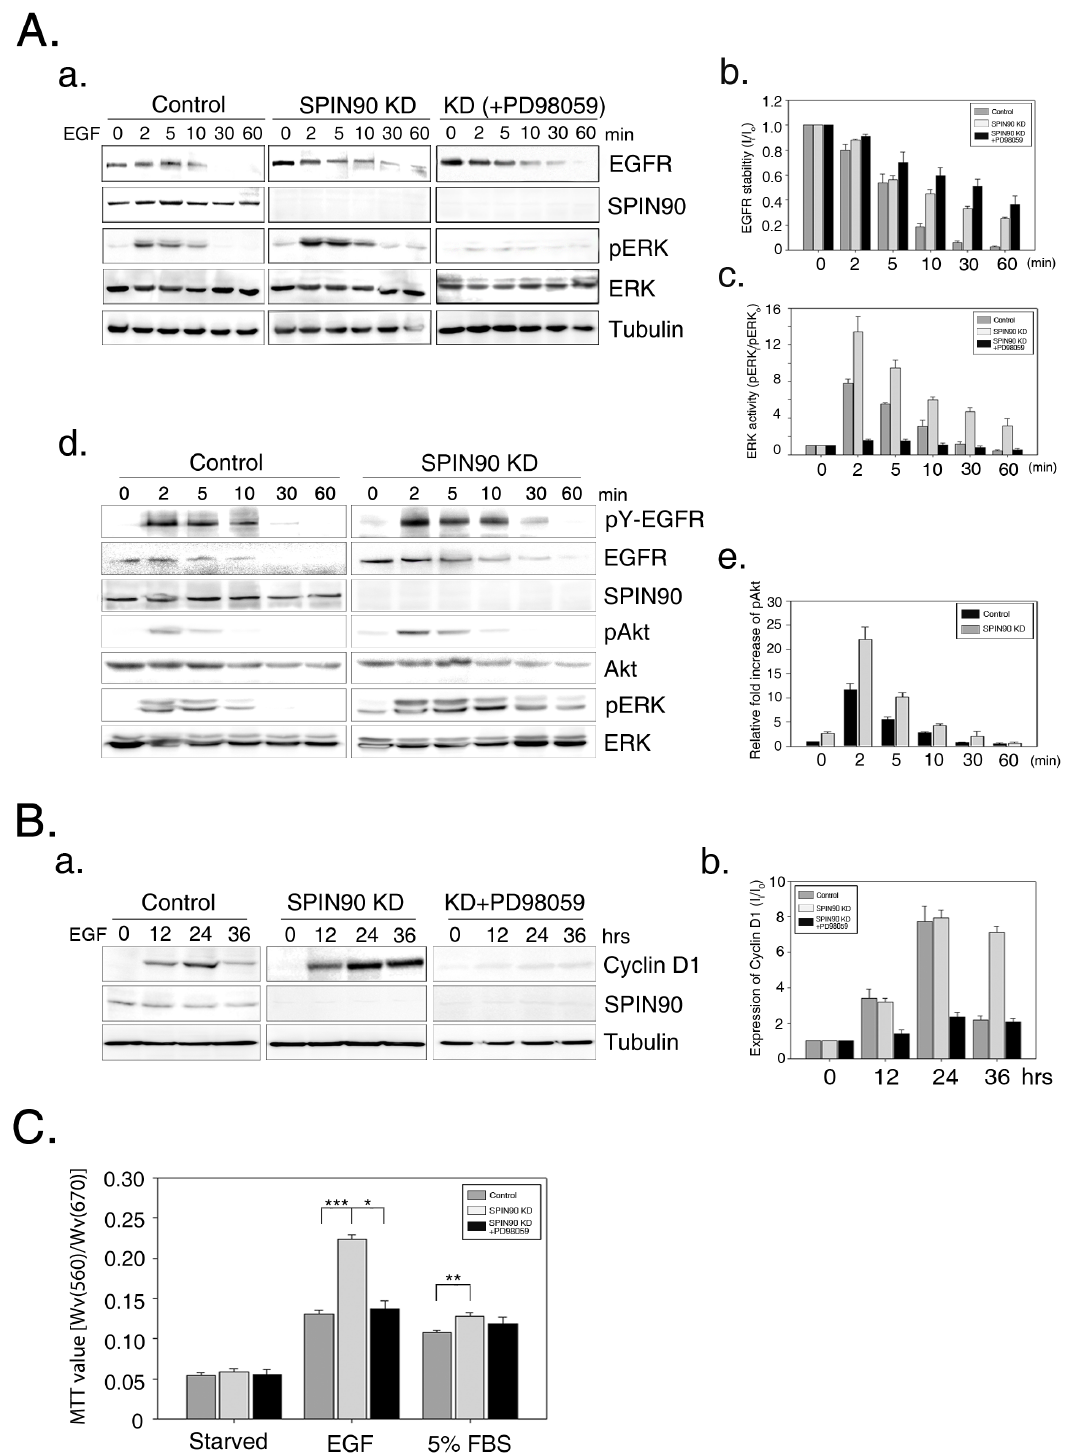
Figure 6. SPIN90 knockdown enhances cell proliferation. A. (a) Control and SPIN90 knockdown (KD) HeLa cells were starved for 16 h, and treated with 40 ng/ml EGF for the indicated times. One set of SPIN90 knockdown cells was treated with 40 ng/ml EGF and 50 m M PD98059 for the indicated times (KD + PD98059). Cell lysates were immunoblotted with the indicated antibodies. (b) Band intensities was normalized to that of tubulin. Bar graphs represent EGFR stability, calculated as the ratio of band intensity of EGFR at the indicated time-points (Ii), compared to that at 0 time (Io). (c) ERK activity is presented as the ratio of band intensity of phospho-ERK (pERK), compared to that of ERK. (d) Experiments were performed the same as Fig. 6A. Cell lysates were immunoblotted with the indicated antibodies. (e) Bar graphs represent active Akt, calculated as the ratio of band intensity of phosphor-Akt (pAkt) compared to total Akt.. B. Control, SPIN90 knockdown (KD) and PD98059 (50 m M)-treated SPIN90 KD HeLa cells starved for 16 h were incubated with 40 ng/ml EGF for the indicated times. PD98059 (50 m M) was used. Cyclin D1 was detected via immunoblot analysis, and the relative values of band intensities calculated. C . Control, SPIN90 knockdown (KD) and PD98059 (50 m M)-treated SPIN90 KD HeLa cells were incubated